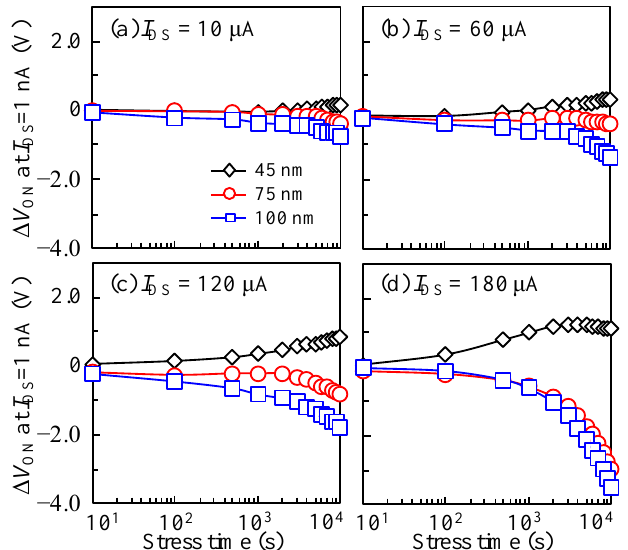
Figure 7. Variation in the ∆ V ON with DCS duration for the TFT devices measured at I DS stresses of ( a ) 10, ( b ) 60, ( c ) 120, and ( d ) 180 μA.